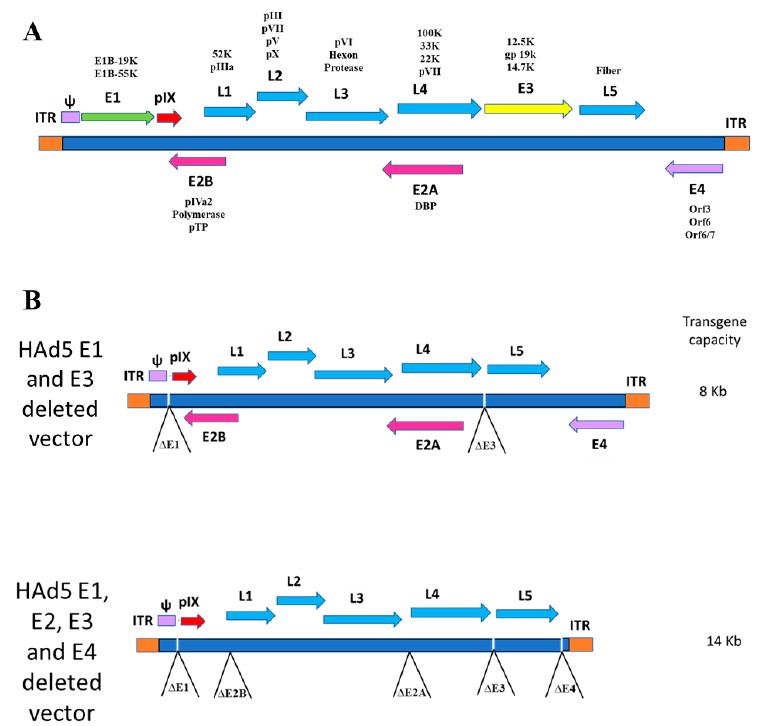
Figure 1. ( A ) The transcriptional map of human adenovirus type 5 (HAd5). It is composed of early (E) region (E1–E4) genes, which are responsible for genome replication, regulation of the viral transcription, and suppression of the infected cell response to the virus. The late gene transcription units (L1–L5) are expressed late in the viral replication cycle leading to the synthesis of the majority of viral structural proteins. ( B ) Diagrammatic representation of HAd5 vaccine vectors. The upper panel represents the vector genome containing the E1 and E3 deletions, and the lower panel shows the vector genome organization consisting of the E1–E4 deletions to increase the insertion capacity of foreign gene cassette.